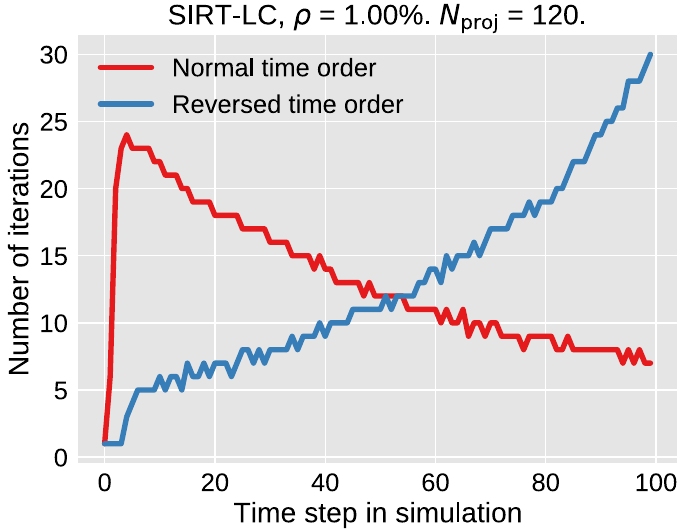
Figure 6. The number of iterations required in each time step before the NCP stopping criteria is met for the case with ρ = 1.00% and N proj = 120 for the SIRT-LC